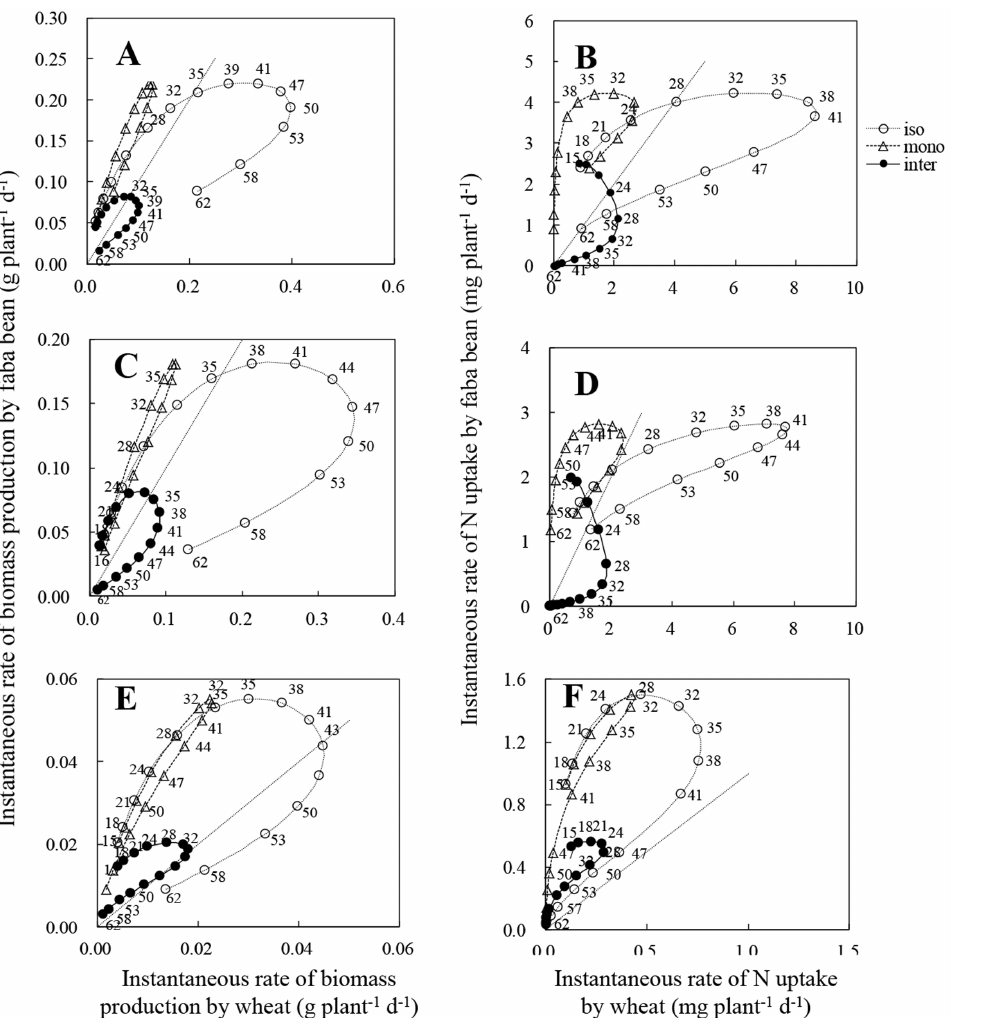
Fig. 6. Trajectories of biomass production and nitrogen (N) uptake of total (A, B), shoot (C, D) and root (E, F) by isolated (iso: open circles and dashed line), monocropped (mono: open triangles and dashed curve), intercropped (inter: solid symbols and continuous line) wheat and according faba bean. Data was derived from the logistic equation using the mean of actual data at each sampling. Numbers near the curves represent the samplings time (day). The dashed line shows the 1:1 relationships between faba bean and